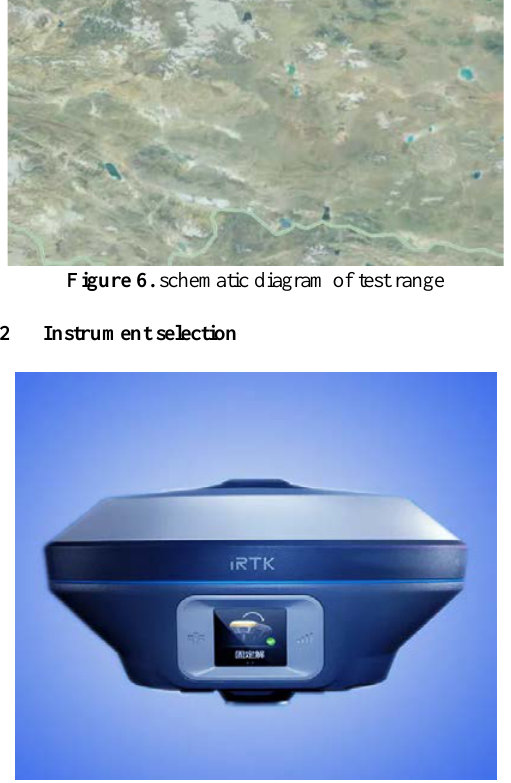
Figure 7. starfish irtk5x GNSS receiver